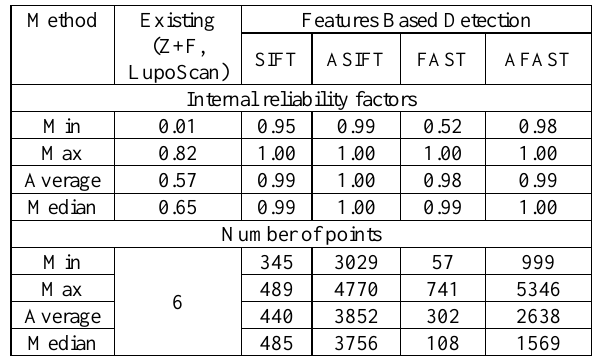
Table 2. The robustness analysis of reliability